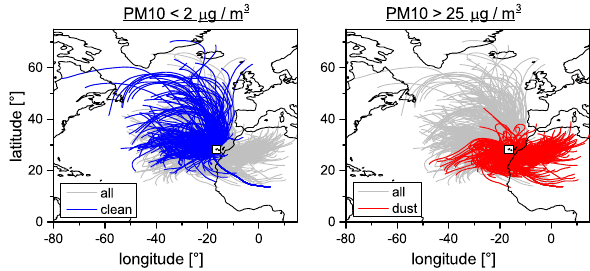
Figure 13. 72h backward trajectories between May and October (2012 and 2013) for Izaña classified with respect to the PM10 value as measured in situ at Izaña. Grey lines: all backward trajectories; blue lines: for PM 10 < 2µgm − 3 ; red lines: for PM 10 > 25µgm − 3